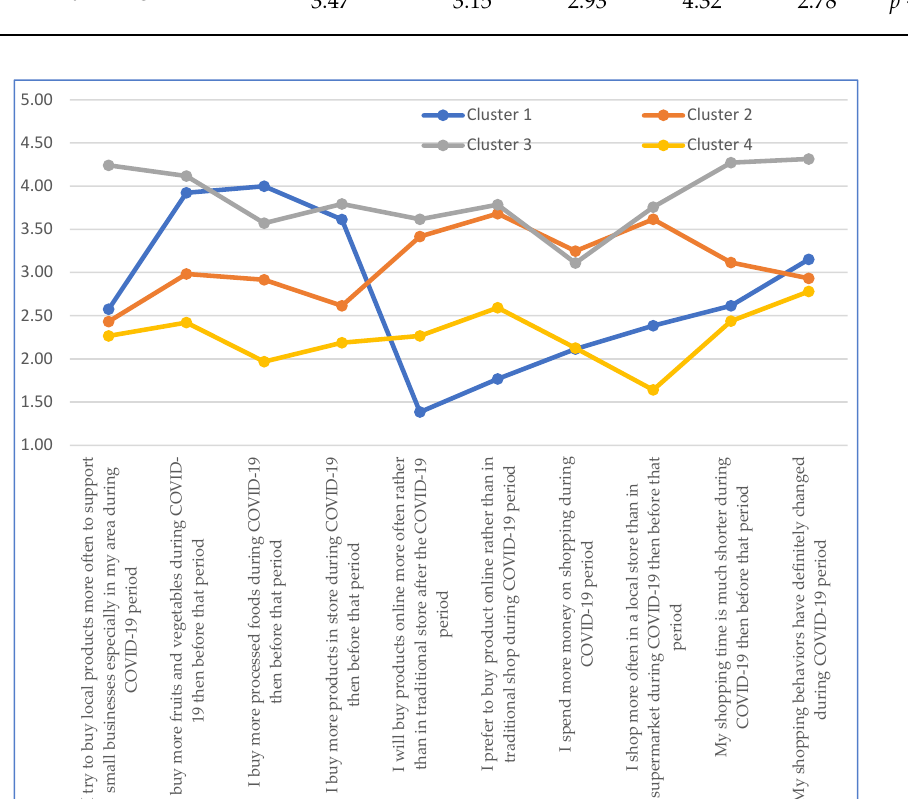
Figure 2. Cluster analysis: European students.